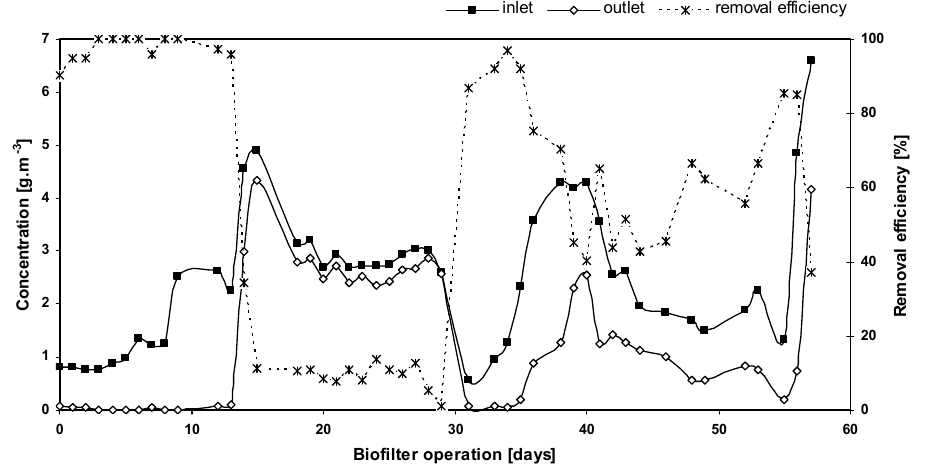
Figure 2. Inlet and outlet butanol concentration in air and removal efficiency during continuous operation of the biotrickling filter (BTF).